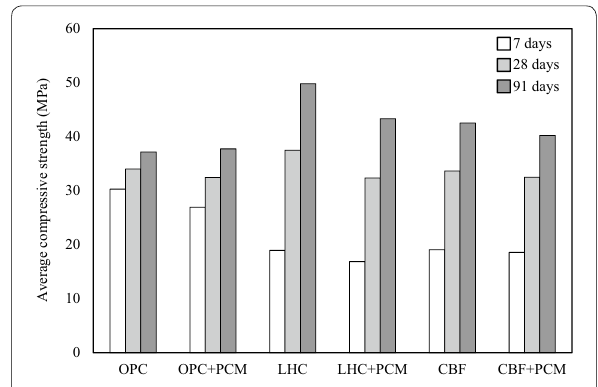
Fig. 4 Average compressive strength with curing age.